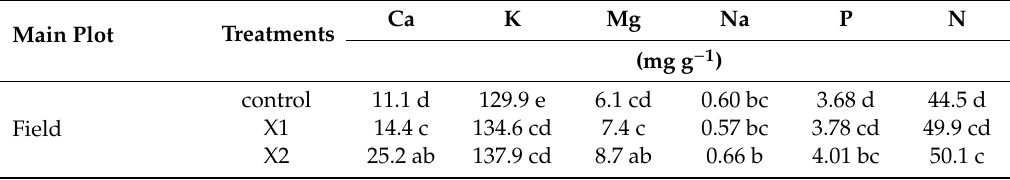
Table 6. Shoot nutrient uptake at 130